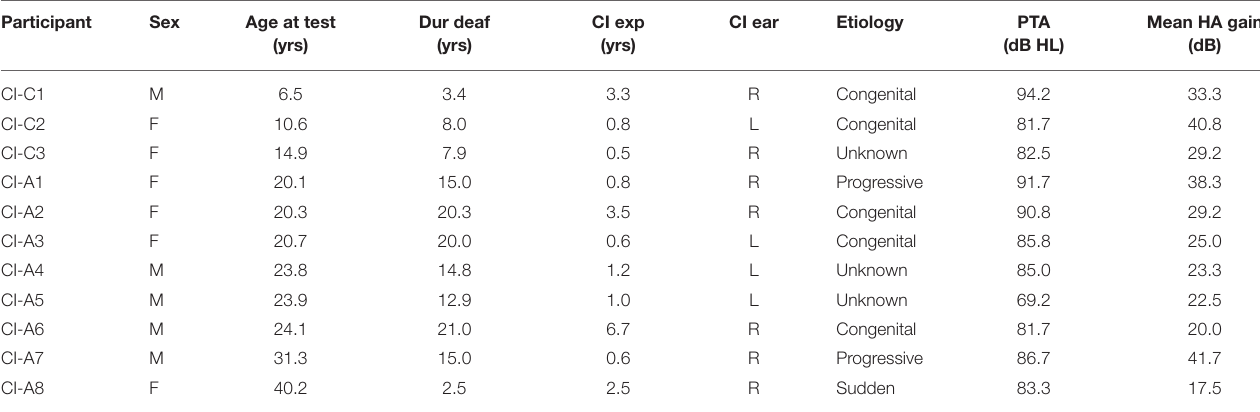
TABLE 1 | Demographic information of CI participants.